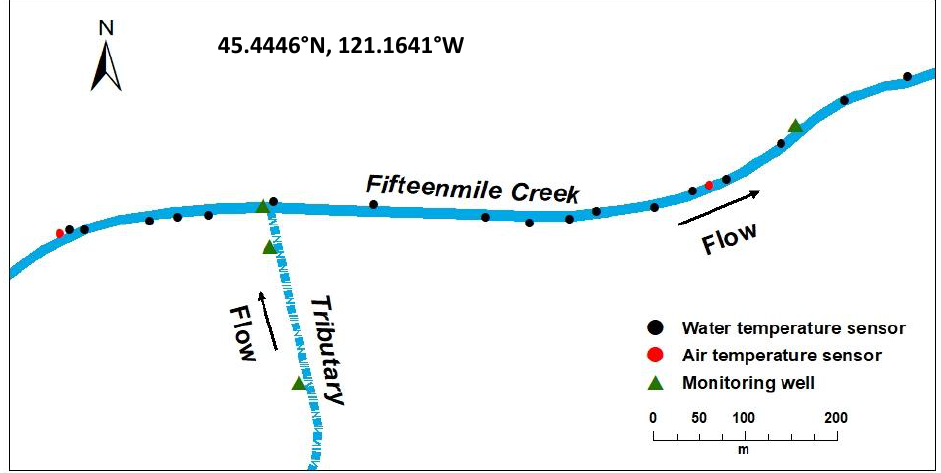
Figure 1. Schematic illustrating the location of instrumentation installed at the 800 m reach along 15-MC and an intermittent